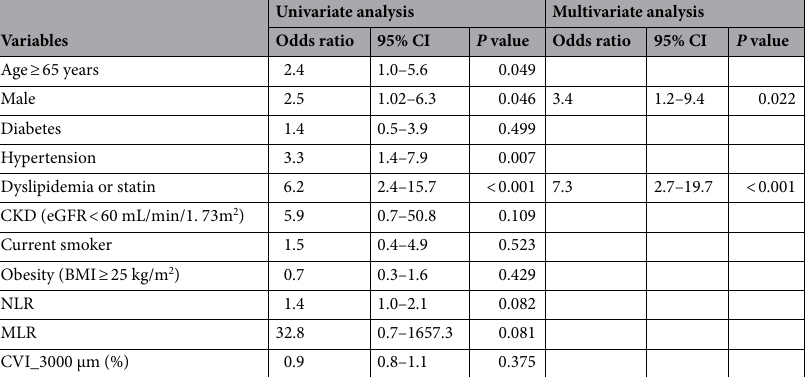
Table 2. Univariate and multivariate logistic regression analyses for factors associated with coronary artery disease. BMI body mass index, CKD chronic kidney disease, CVI choroidal vascularity index, eGFR